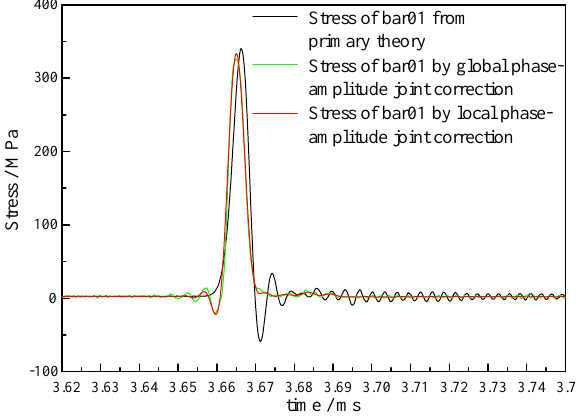
Figure 16. Comparison of the stress curve of pressure bar 01 with different methods.